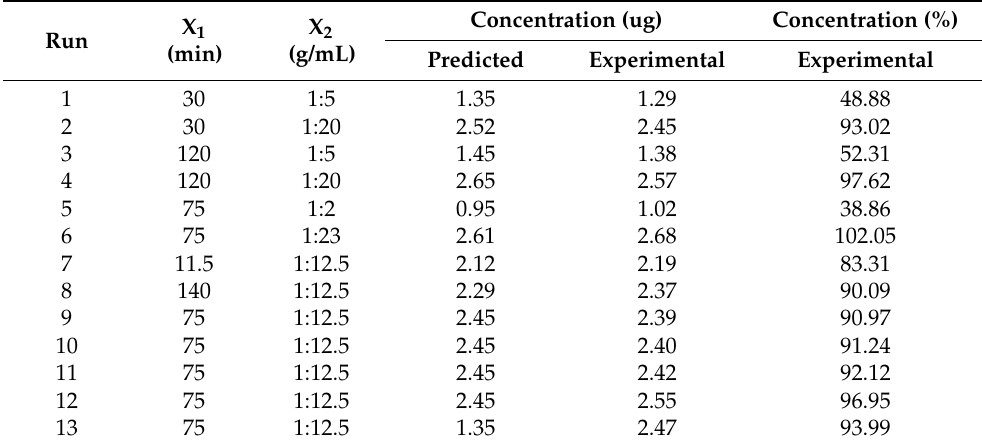
Table 1. Experimental matrix according to the central composite design (CCD) and response for extraction of isoimperatorin.